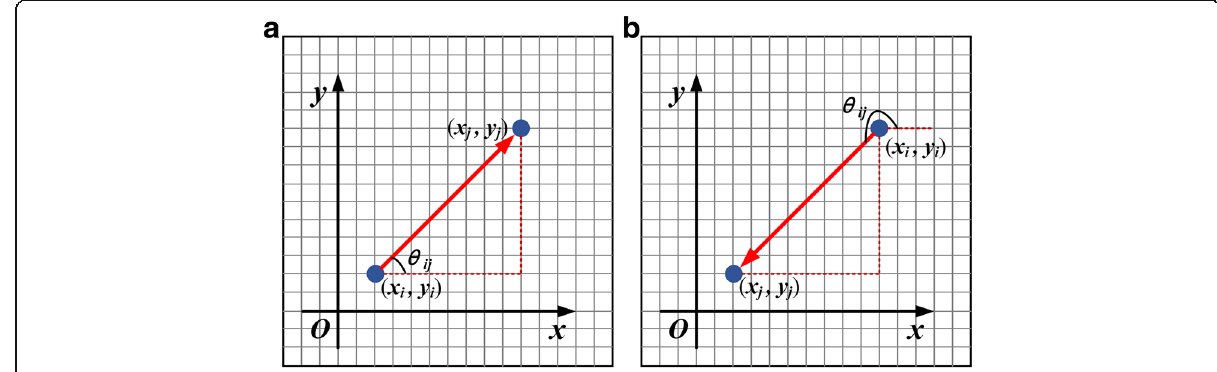
Fig. 4 The diagram of the ray angle θ ij from v i to v j , where the θ ij in a is a acute angle, and the θ ij in b is a obtuse